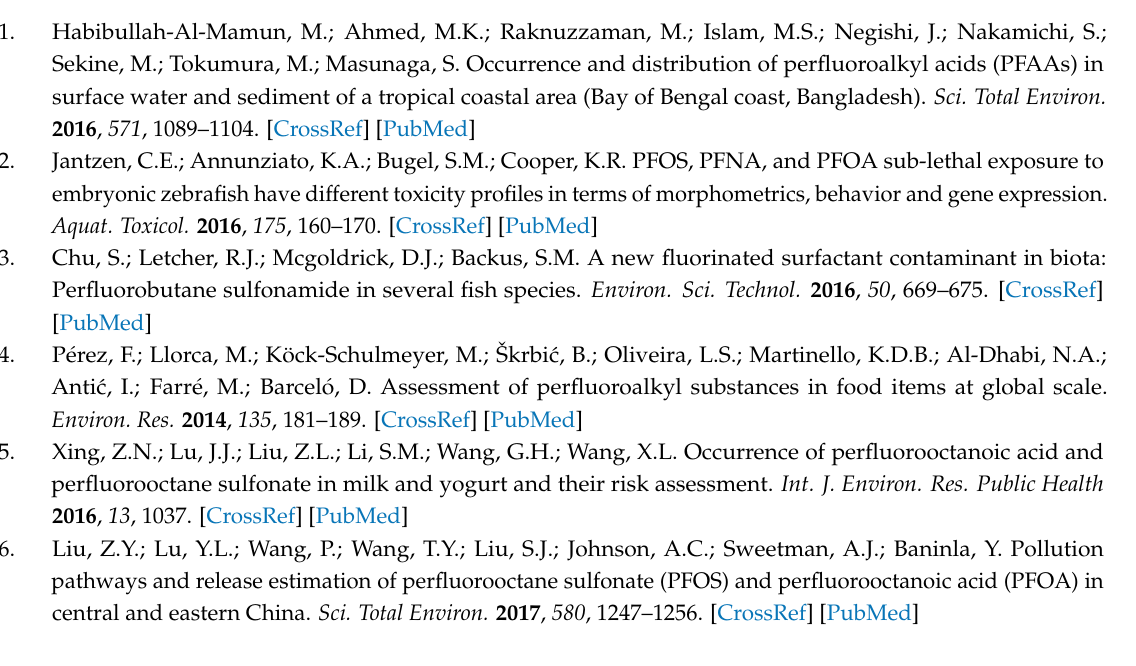
Table S1: The MS optimize parameters of 13 PFAAs and 2 internal standards, Table S2: Linear equation, correlation coefficient, LODs, LOQs, recovery and RSDs of 13 PFAAs in beef muscle and beef